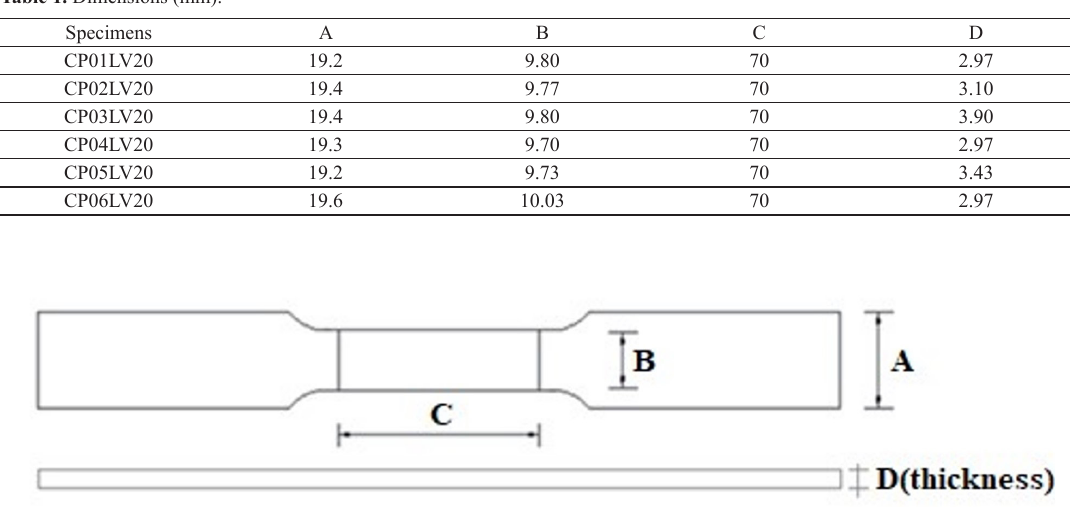
Figure 2. Test specimen dimension references.